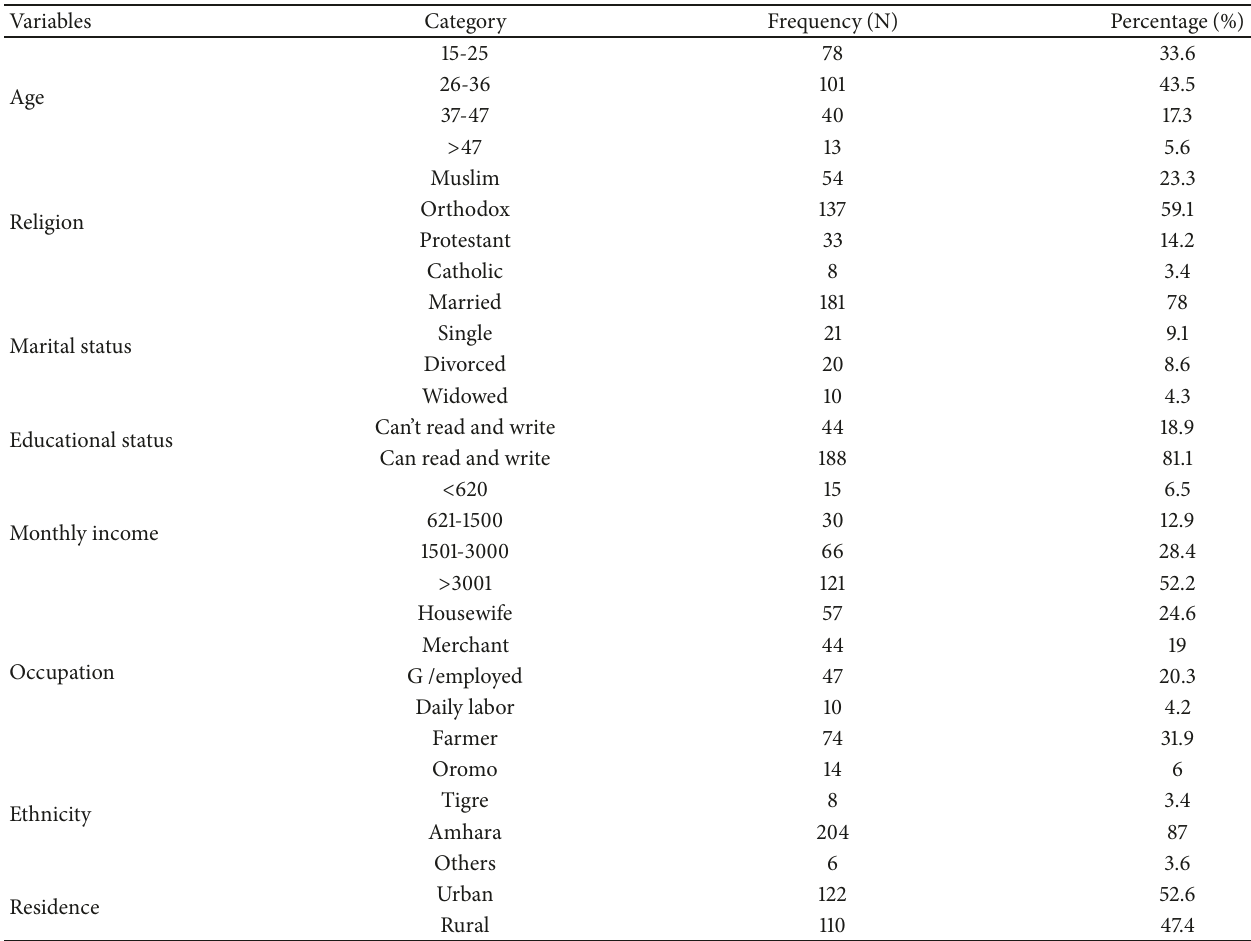
Table 1: Sociodemographic characteristicsof women delivered at Dangla Primary Hospital, Awi Zone, Amhara Region, Northwest Ethiopia, 2017